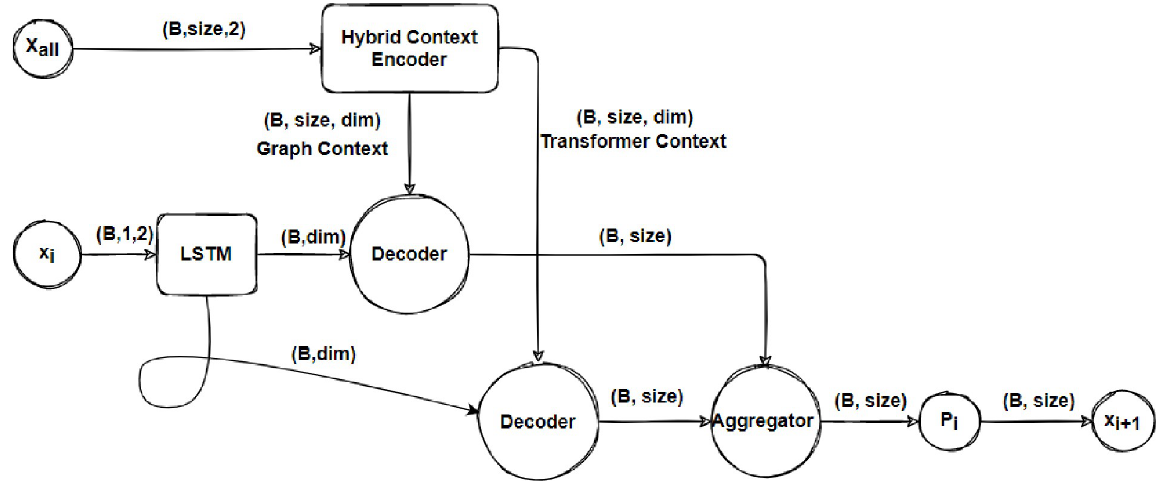
Fig 1. Architecture of HPN which combining a hybrid context encoder with a multi-attention decoder.